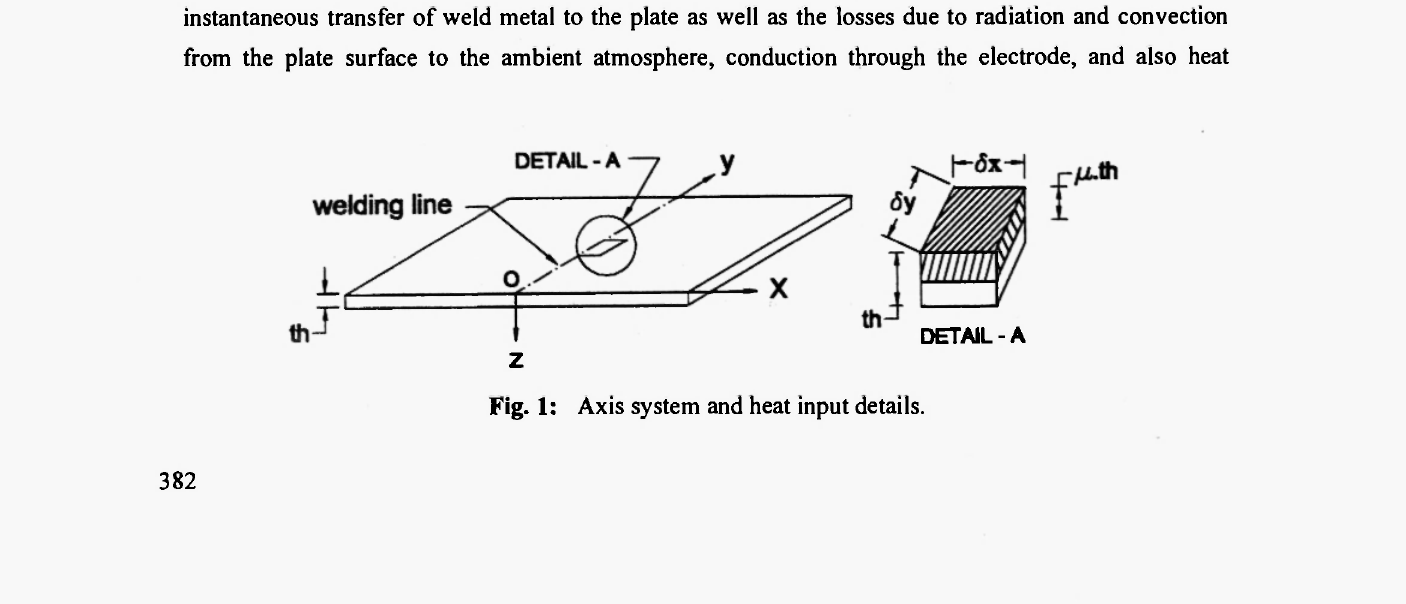
Fig. 1: Axis system and heat input